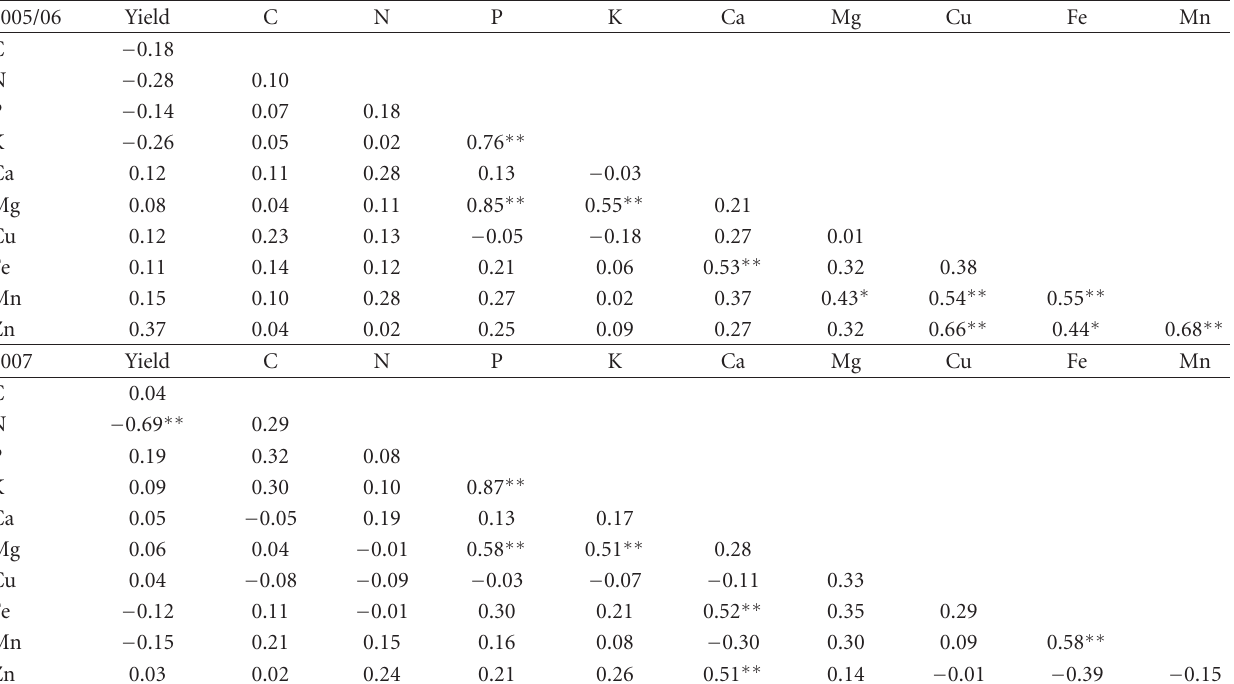
Table 6: Correlation between nutrients (macro and micro) concentration and yield for ten corn cultivars representing five di ff erent technological levels, harvesting in 2006 and 2007, at Rolandia County, Paran´a State, Brazil.